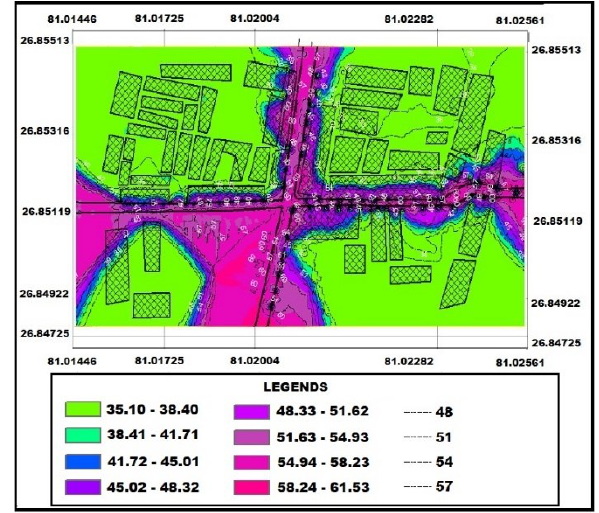
Figure 3. Noise level map of Haniman crossing for unorganized road for morning time.